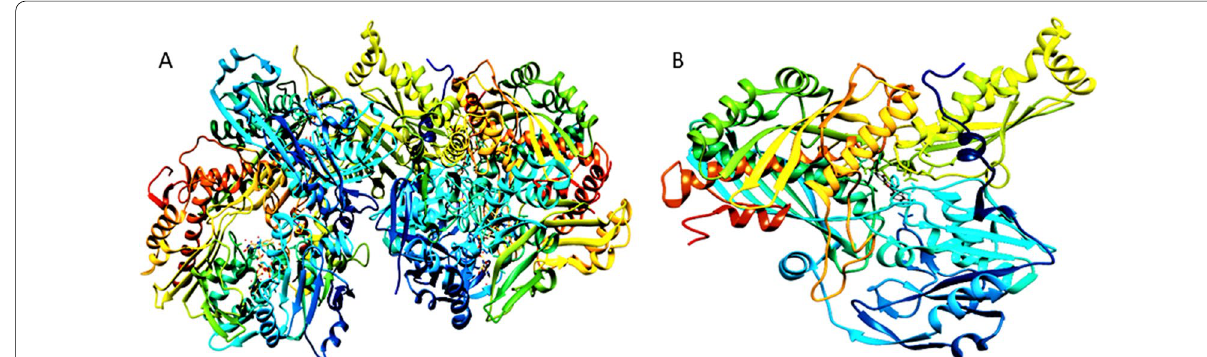
Fig. 1 X-ray crystal structure of A : Bovine milk xanthine oxidase homodimer and B : C-terminal domain of one of its monomers. Chimera 1.4 was used to remove five of the six chains of the homodimer, leaving only one of its two C-terminal domains used for in silico studies. (PDB ID 3NVY, 2.00